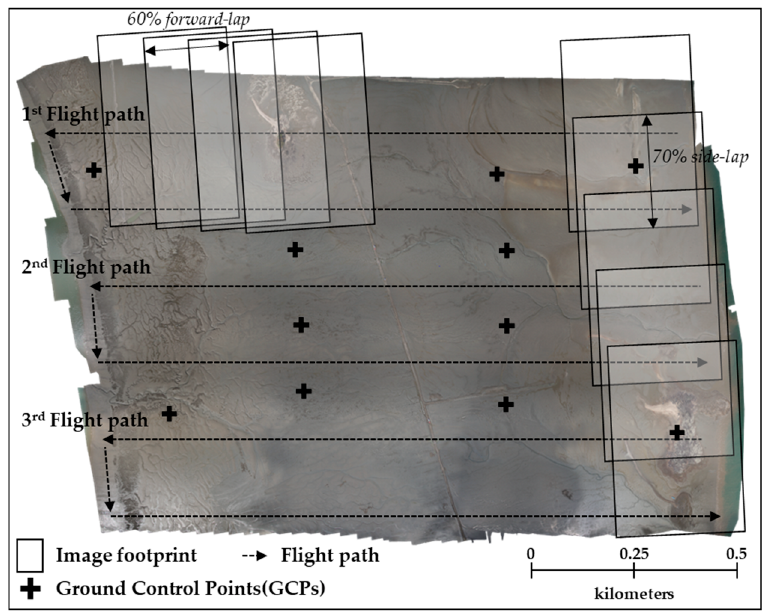
Figure 2. Flight paths of UAV. The squares are image footprints, which had 70% side-lap and a 60% forward-lap. The crosses are GCP.